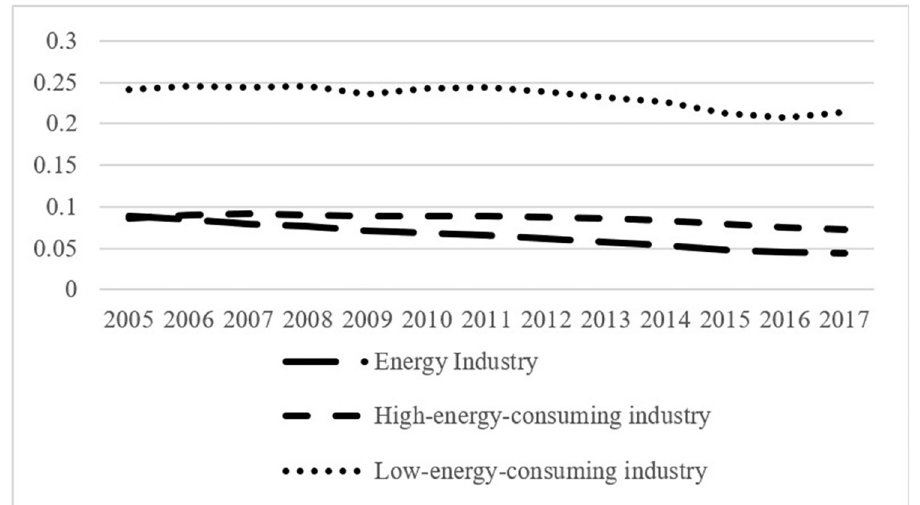
Fig 2. Changes in the internal industrial structure of industry during 2005–2017 (proportion of the total GDP).